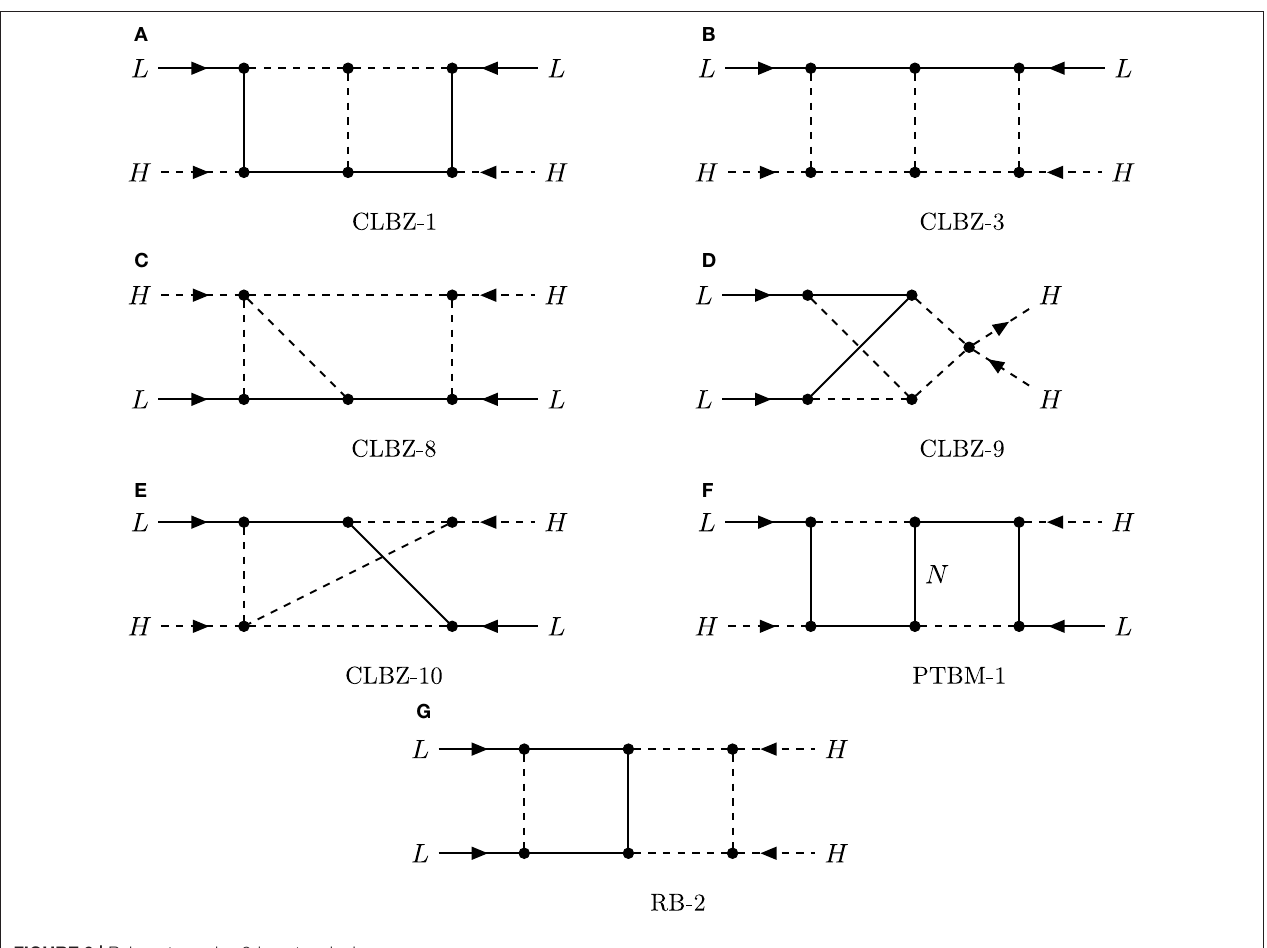
FIGURE 9 | Relevant genuine 2-loop